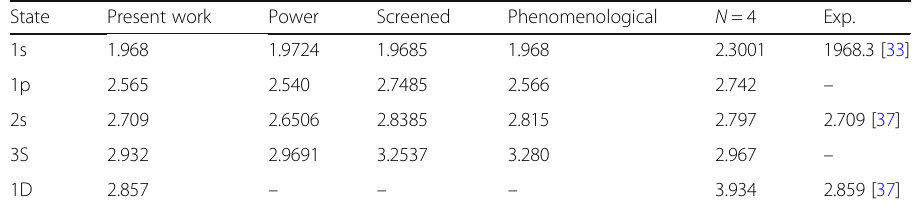
Table 4 Mass spectra of cs meson in (GeV) ( m c = 1.628, m s = 0.419 GeV, a = 0.48 GeV 2 , b = 3.795, d